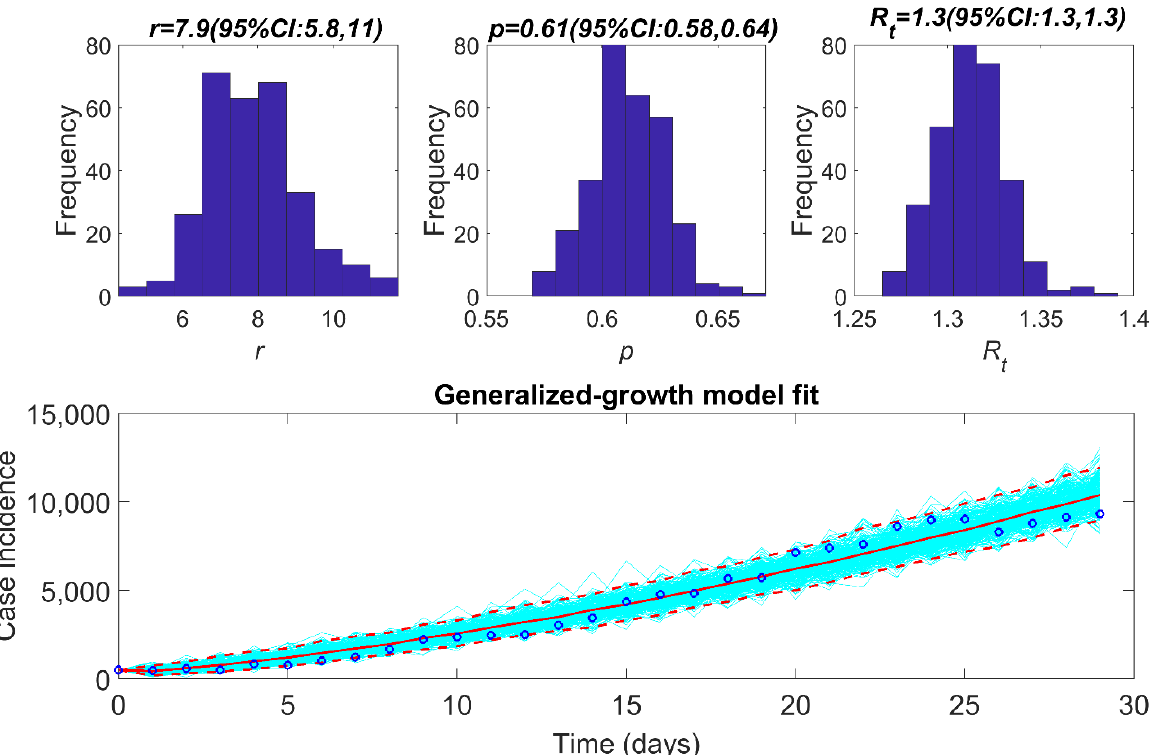
Figure 9. Upper panel: reproduction number for Nepal for the early phase of the second wave of epidemic (12 April 2021 – 11 May 2021) with 95% CI estimated using the GGM model. The estimated reproduction number of the COVID-19 epidemic in Nepal as of 12 May 2020, is 1.3 (95% CI: 1.3, 1.3). The growth rate parameter, r , is estimated at 7.9 (95% CI: 5.8, 11) and the deceleration of growth parameter, p , is estimated at 0.61 (95% CI:0.58, 0.64). Lower panel: the lower panel shows the GGM fit to the case incidence data for the first 30 days of the second wave from 12 April 2021 – 11 May 2021. Table 4. Comparison of reproduction number estimated using GGM for provinces, for first 30 days of second wave (12 April – 11 May 2021).